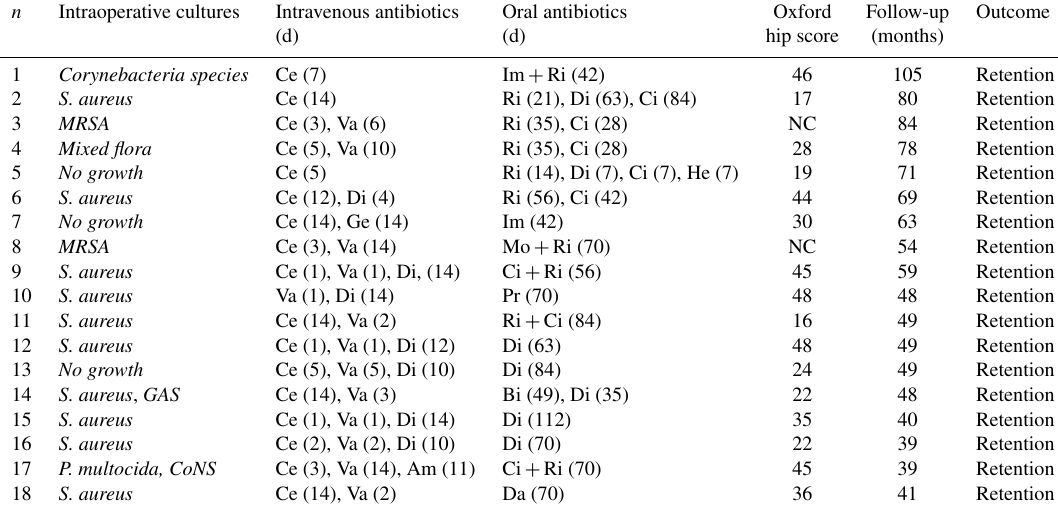
Table 2. Intraoperative microbiology, antibiotic therapy, OHS, follow-up, and outcome. n Intraoperative cultures Intravenous